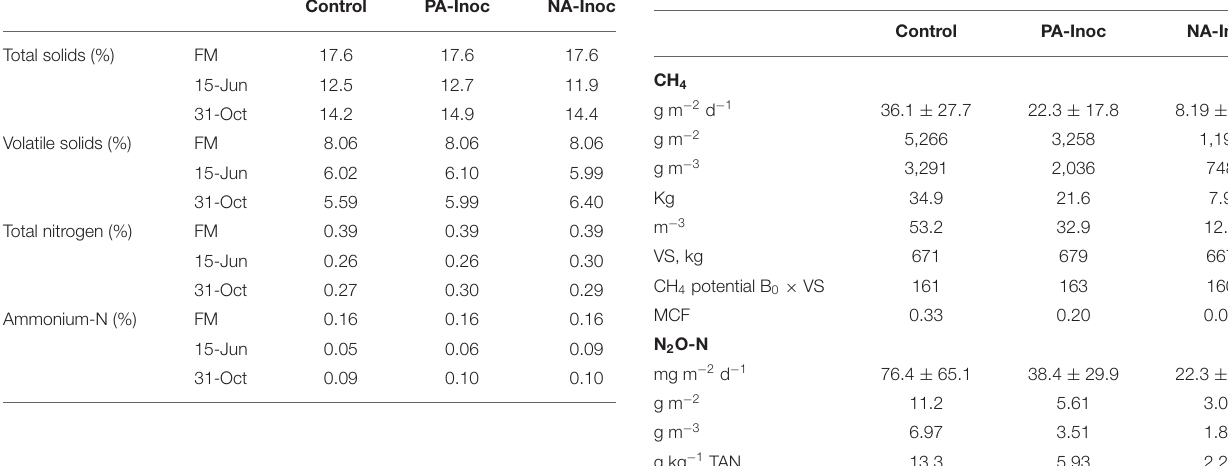
TABLE 3 | Total (g m − 2 ; g m − 3 ; kg; m 3 ) and daily mean (g m − 2 d − 1 )